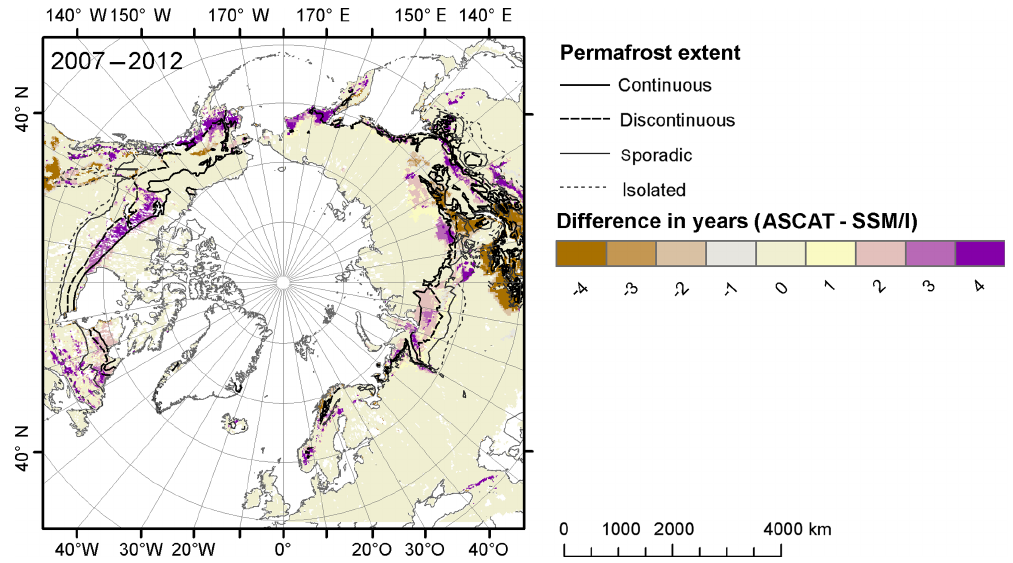
Figure 8. Comparison of the total number of years classified as permafrost between Metop ASCAT (FT) and SSM/I for 2008–2012 based on the 0 ◦ C temperature threshold method applied to all years (minimum of 2 consecutive years with below 0 ◦ C). Source of permafrost extent classes is Brown et al.